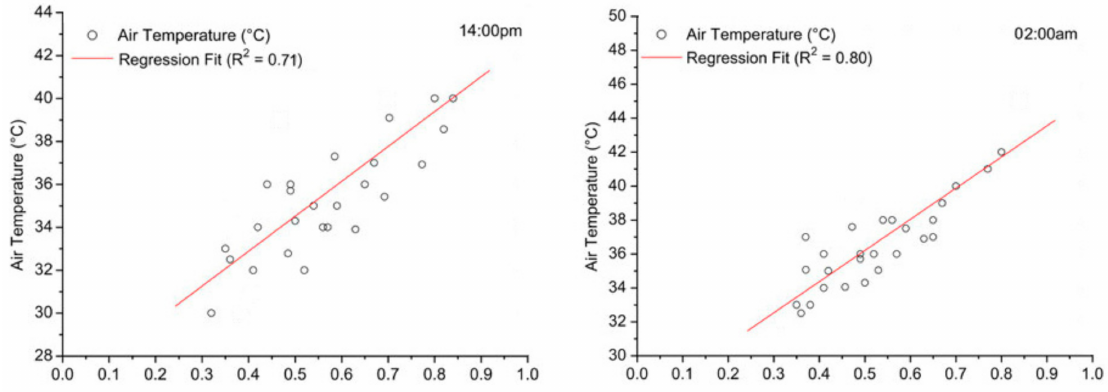
Figure 12. Linear fitting relationship between sky view factor and air